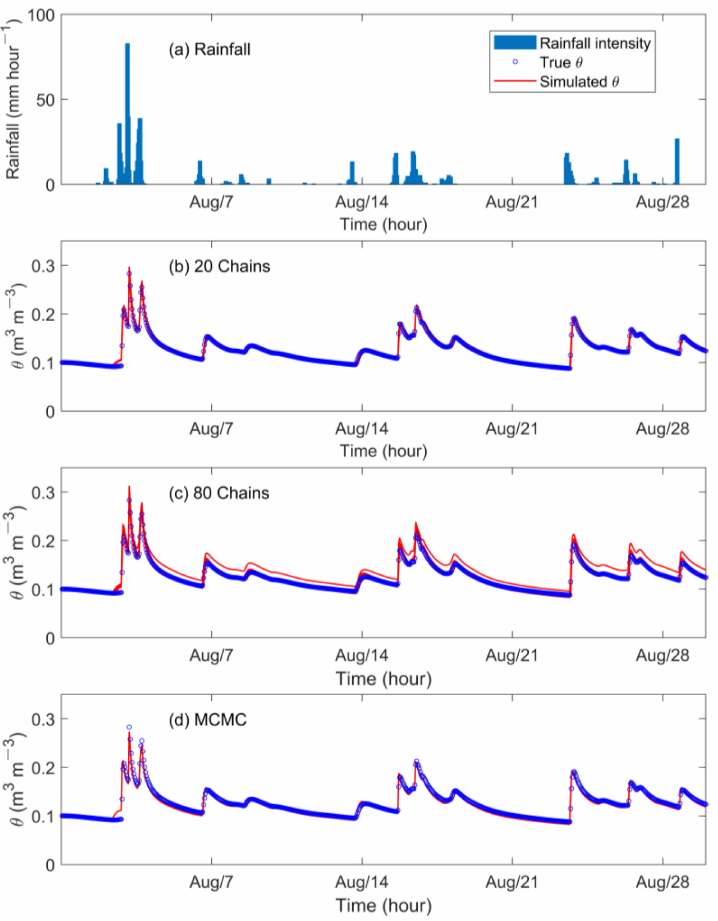
Figure 5. Ensemble of simulated soil moisture content (red lines) in comparison with true values (black round